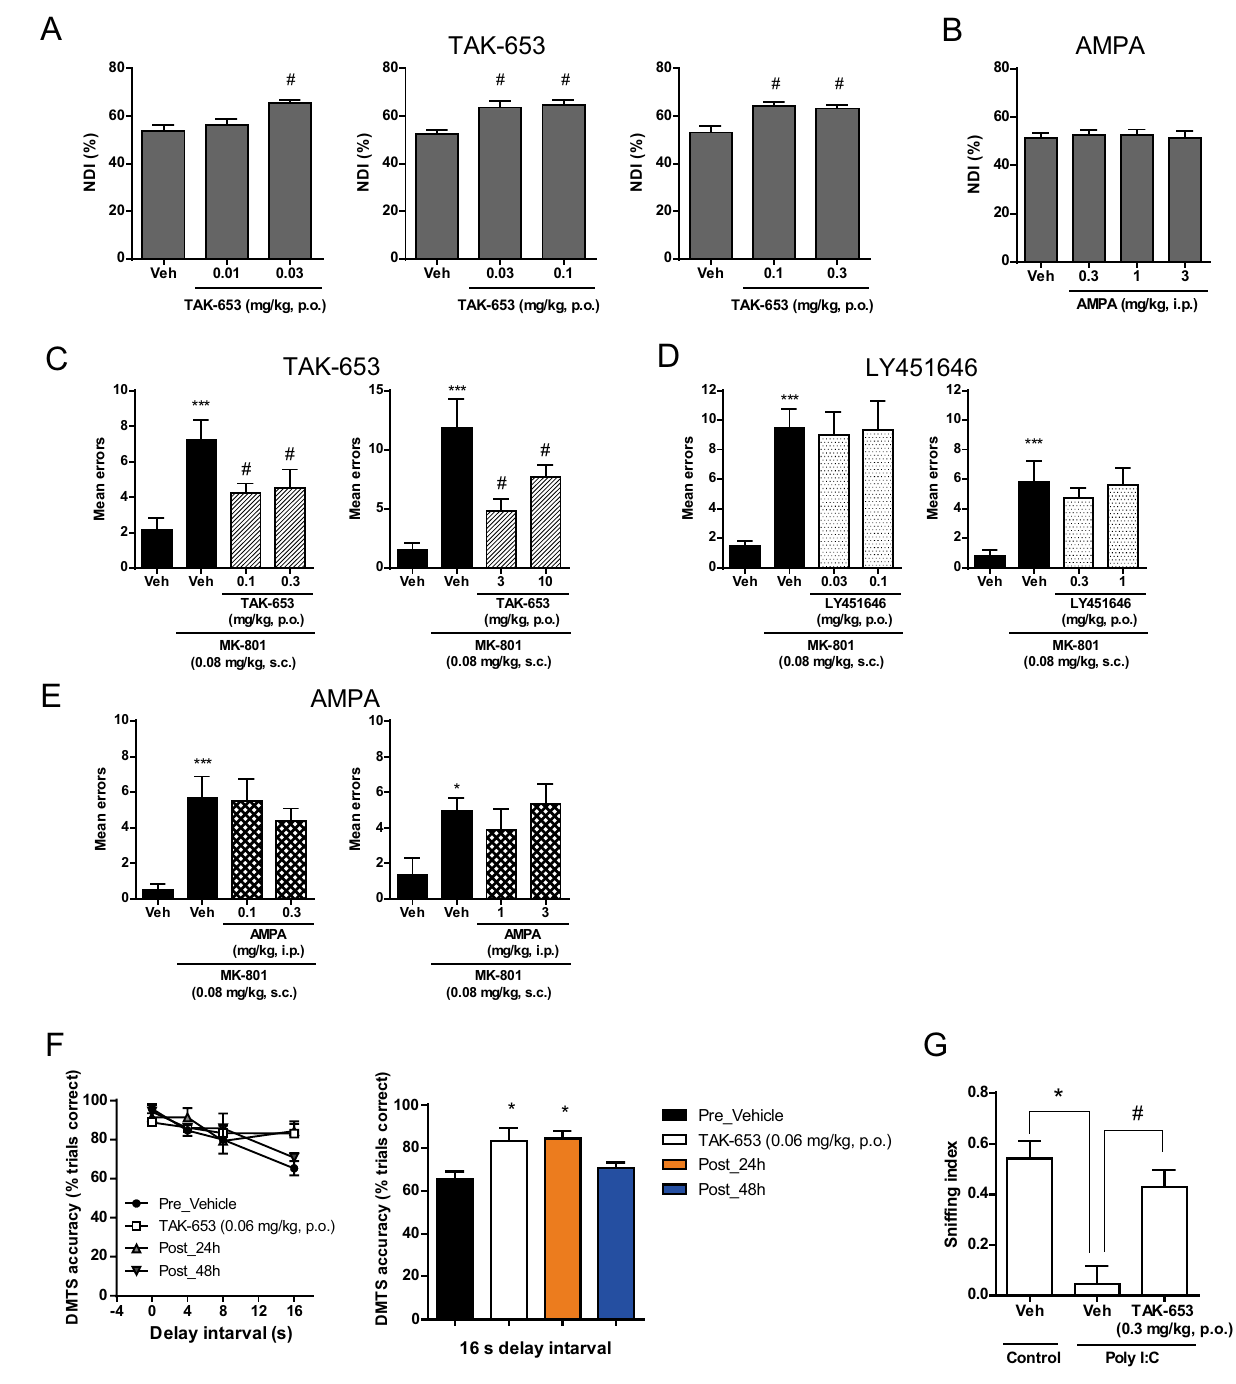
Figure 4. Effect of TAK-653, LY451646, and AMPA on cognitive functions in multiple domains. ( A ) Effect of TAK-653 on visual learning and memory in NOR test using naïve rats. TAK-653 (0.01 and 0.03 mg/kg, p.o., 0.03 and 0.1 mg/kg, p.o., and 0.1 and 0.3 mg/kg, p.o.) was administered to rats 2 h prior to the acquisition and the retention trials. ( B ) Effect of AMPA on visual learning and memory in NOR test using naïve rats. AMPA (0.3, 1 and 3 mg/kg, i.p.) was administered 0.5 h prior to the acquisition and the retention trials. NDI data were presented as the mean ± SEM (n = 10). # P ≤ 0.05 (versus vehicle-treated group; two-tailed Williams’ test). ( C – E ) Effect of TAK-653 ( C ), LY451646 ( D ) or AMPA ( E ) on working memory in RAM test using rats. At 1.5 h, 1 h or 0 h before administration of vehicle or MK-801 (0.08 mg/kg, s.c.), TAK-653, LY451646 or AMPA, respectively, was administered to rats. Thirty minutes after dosing of MK-801, rats were placed on the maze, and then the entry into the arm was recorded. The mean errors were indicated as the mean ± SEM (n = 6–18). *** P ≤ 0.001 (versus vehicle-vehicle group; Welch’s test); # P ≤ 0.05 (versus vehicle-MK-801 group; two-tailed Shirley-Williams’ test). ( F ) Effect of TAK-653 on working memory in DMTS test using monkeys. TAK-653 at 0.06 mg/kg was orally administered to monkeys at 6 h prior to DMTS testing. Each plot at 0, 4, 8 or 16 s interval were presented as the mean ± SEM within 96 trials per session (n = 3) (left). TAK-653 significantly ameliorated DMTS accuracy at 16 s delay interval (right). * P ≤ 0.05 (versus vehicle group; paired t test). ( G ) Effect of TAK-653 on sociability deficits in the social approach-avoidance test in poly- I:C mouse. TAK-653 at 0.3 mg/kg was orally administered to mice at 1 h prior to test session. Sniffing index data were presented as the mean ± SEM (n = 7). * P ≤ 0.05 (versus control mice group; Student’s t test); # P ≤ 0.05 (versus control mice group; Student’s t